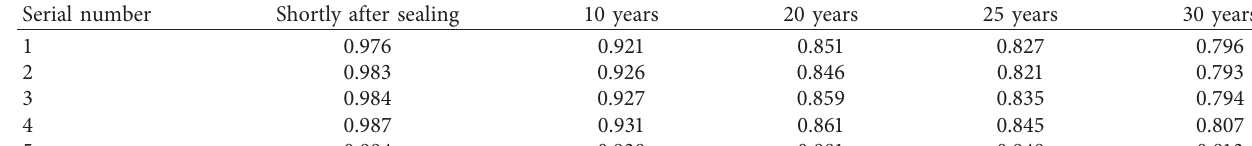
Table 5: Reliability of 5 sealed structure joints.